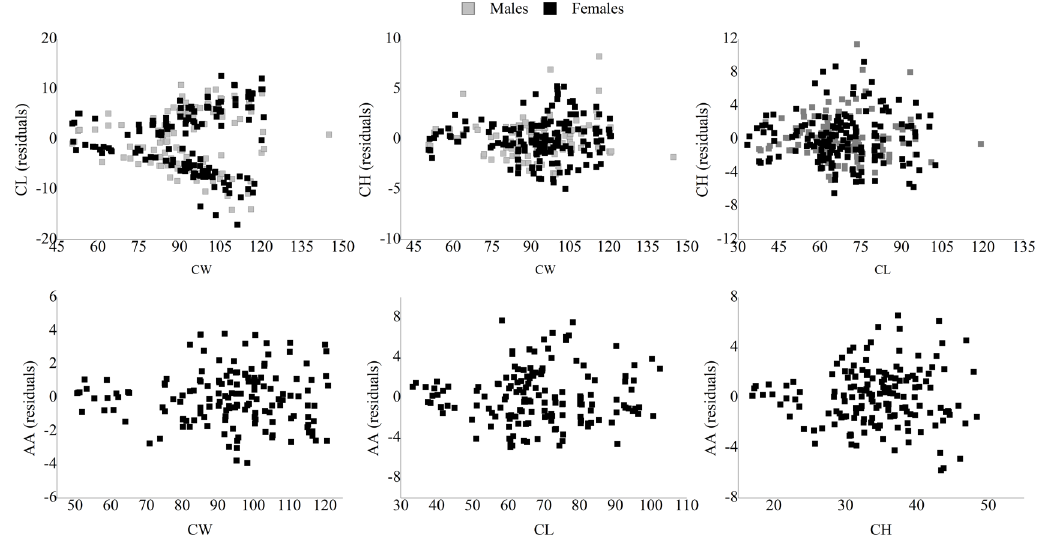
Figure 6. Residual values from the best models fitted to the morphometric data of Menippe frontalis in the Gulf of Guayaquil, Ecuador. CW, carapace width; CL, Carapace length; CH, carapace height; AW, abdomen